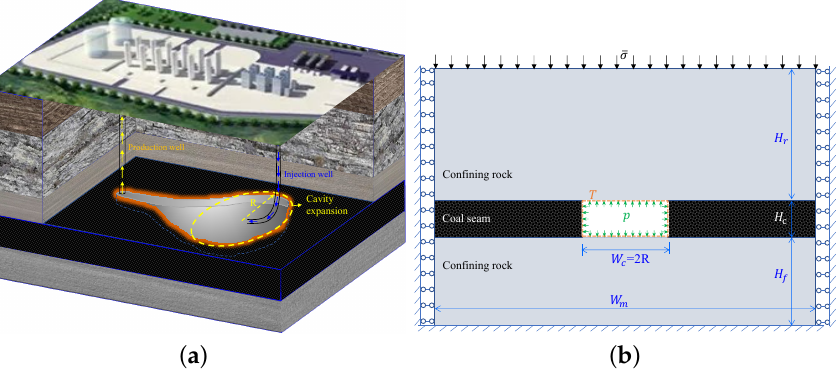
Figure 1. A cavity of underground coal gasification and the involved numerical model. ( a ) Prototype; ( b ) Numerical